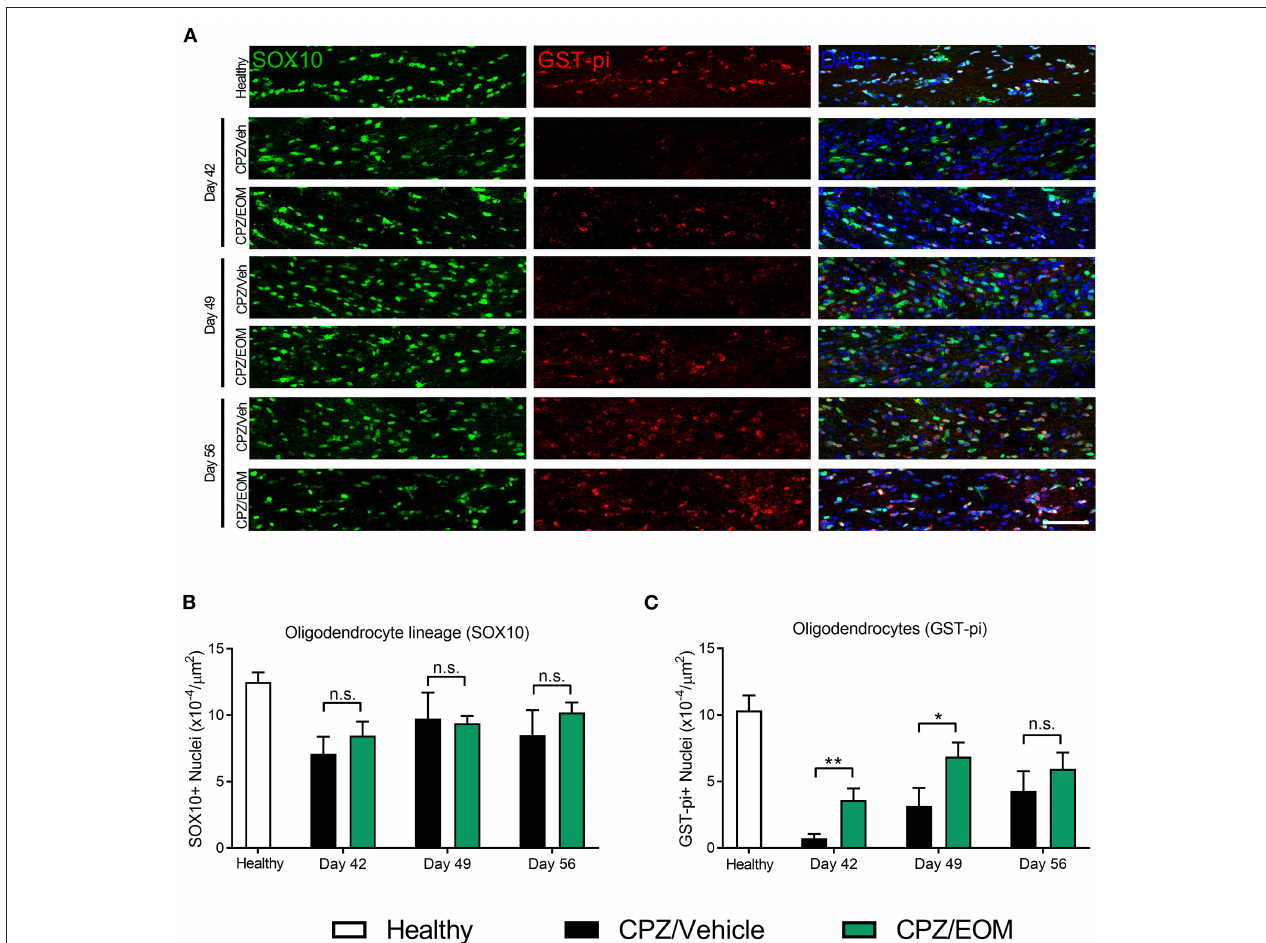
FIGURE 5 | EOM SalB administration changes the number of oligodendrocytes in the corpus callosum of mice administered 0.3% cuprizone (CPZ). (A) Representative images showing DAPI-positive nuclei (blue), SOX10-positive cells identifying all cells within the oligodendrocyte lineage (green) and mature GST-pi-positive mature oligodendrocytes (red) in the region of interest. Scale bar is 100 µ m. (B) The number of SOX10-positive cells was not significantly altered following EOM SalB treatment (0.3 mg/kg). (C) EOM SalB administration increased the number of GST-pi-positive oligodendrocyte cells at days 42 and 49 compared to the vehicle-treated control mice. Images were analyzed using Cell Profiler in 3 sections per animal (averaged), n = 5–6 mice per treatment. Unpaired t-test. Data presented as mean ± SEM. * p < 0.05, ** p < 0.01, n.s. not